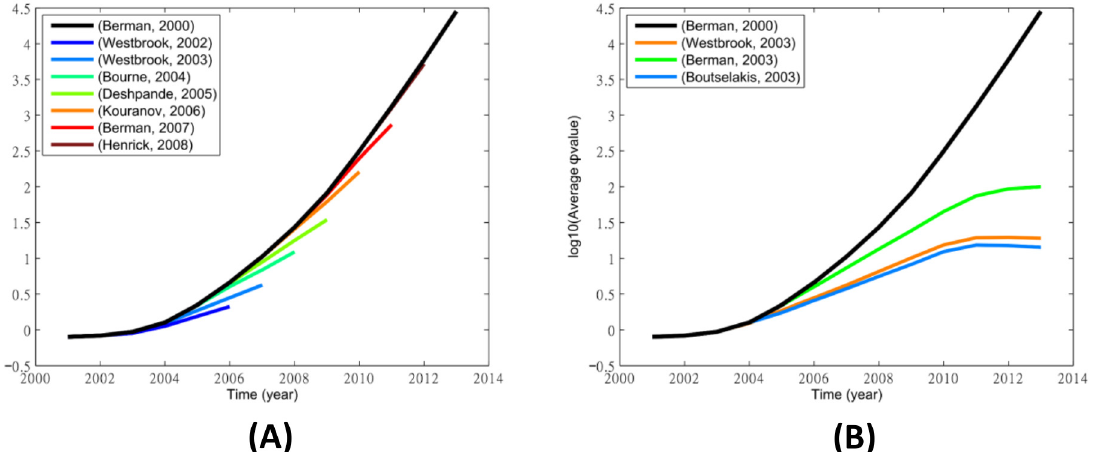
Fig 4. Compare the growth of the PDB debut paper ’ s cascade with (A) all the residue cascades created by its follow-up articles in 5 years ( τ = 5) and (B) the residue cascades created by three 2003 follow-up articles. The y-axis of both panels shows the logarithm of the annual average cascade function values Φ , defined in Eq